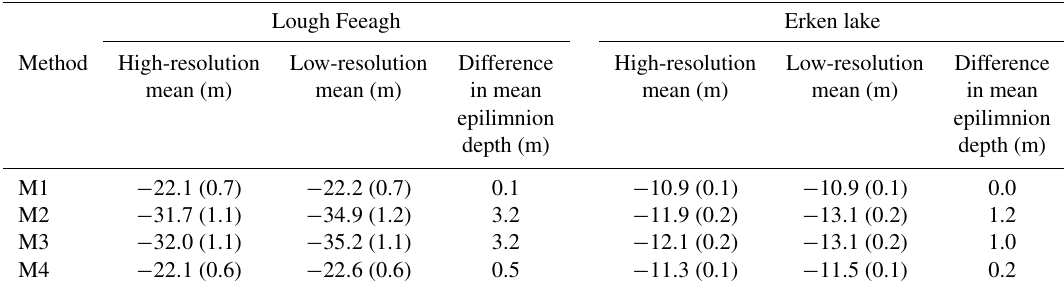
Table 4. Mean April–October epilimnion depth estimates (m) derived using high-resolution and low-resolution modelled water temperature data, with standard error of the mean in brackets, and the difference calculated between the high-resolution and low-resolution estimates (m) for Lough Feeagh and Erken lake.